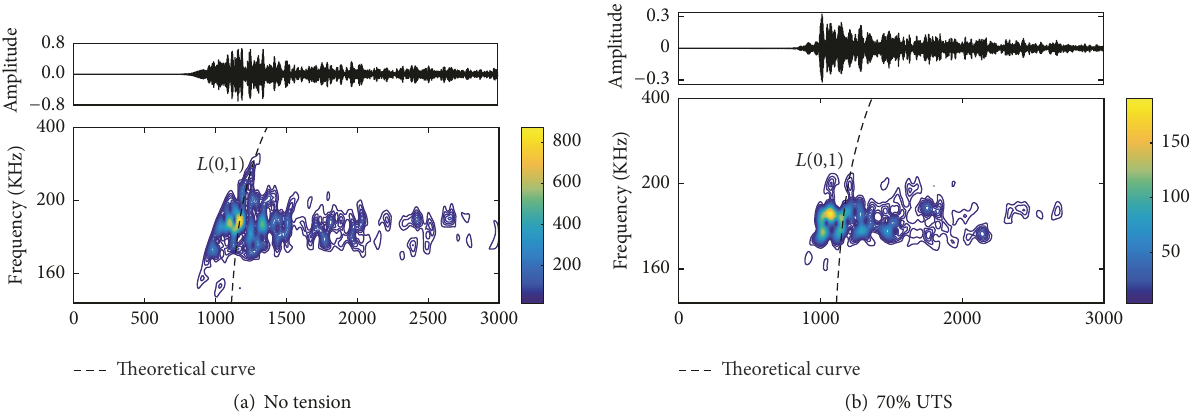
Figure 10: UGW time-frequency energy distribution.